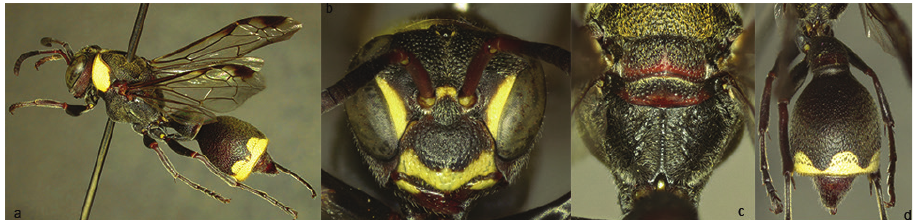
Figure 1. Ropalidia amabala sp. nov., female a habitus b head c scutellum, metanotum and propodeum d T2,